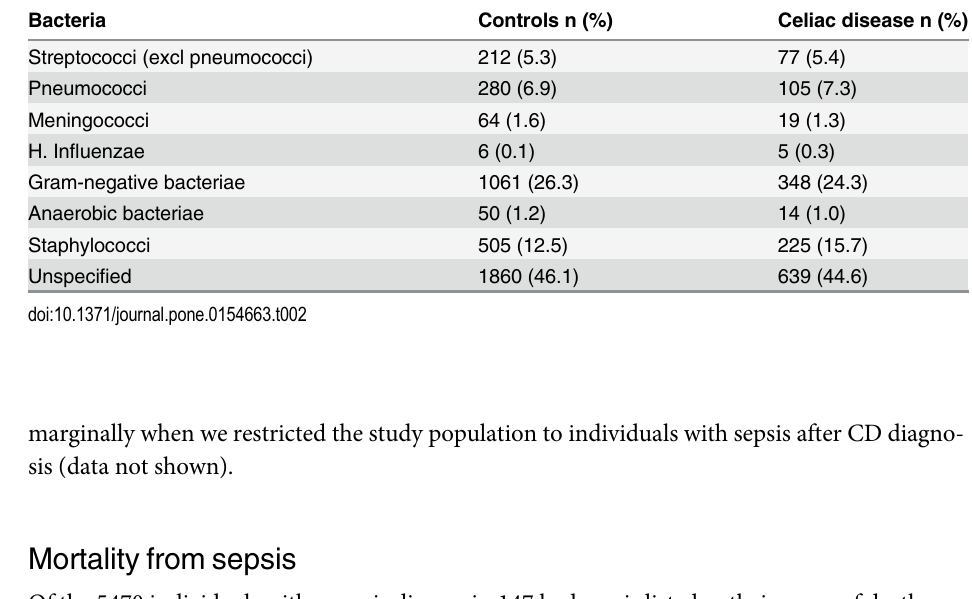
Table 2. Distribution of sepsis according to bacterial origin.